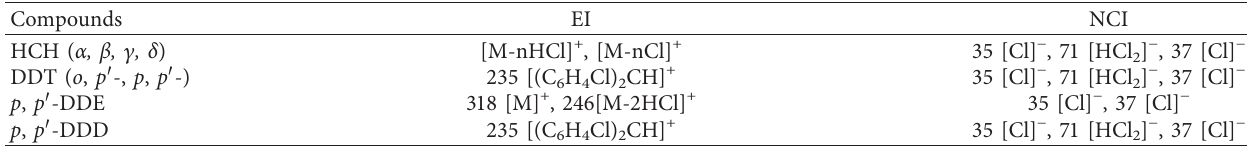
Figure 2: A comparison of mass spectrum from electron ionization (EI) and negative chemical ionization (NCI) of α -hexa- chlorocyclohexane ( α -HCH). (a) EI mass spectrum extracted from NIST Database V 2.0; (b) NCI mass spectrum in SCAN mode obtained in this study. Table 1: Main ions and fragments of eight organochlorine pesticides obtained from electron ionization (EI) and negative chemical ionization